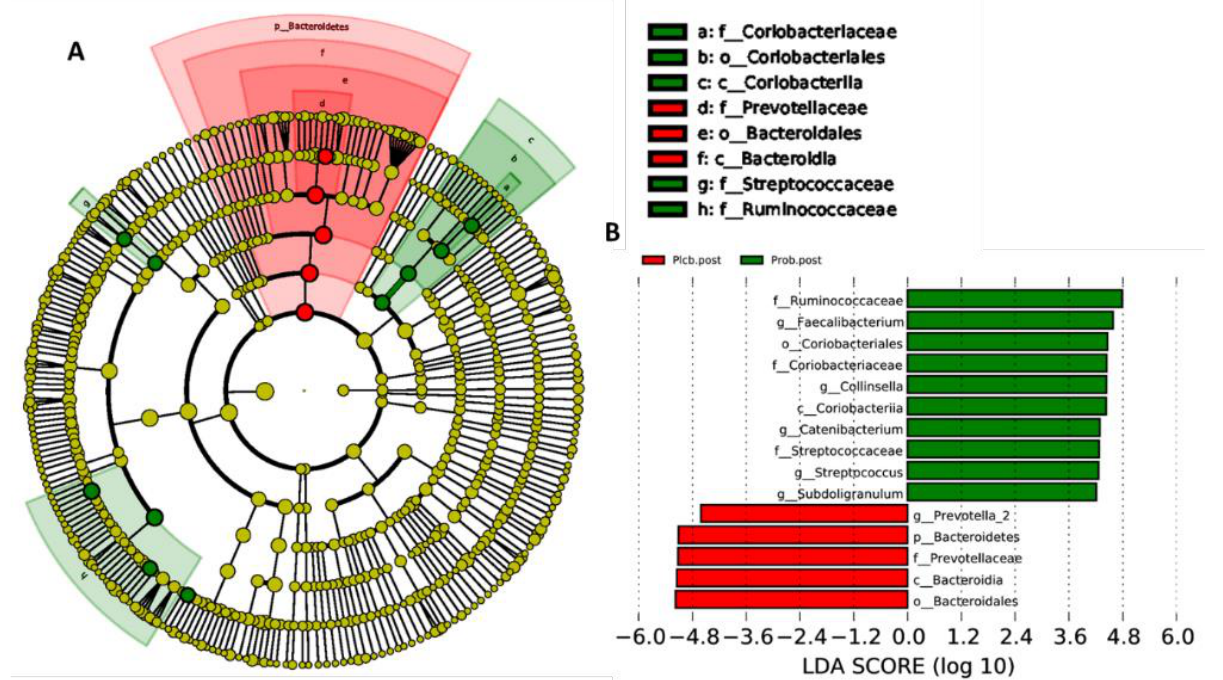
Figure 8. LEfSe analysis identified gut microbiota biomarkers between the placebo and probiotic groups after 50 days of intervention. ( A ) Cladogram and ( B ) LDA scores.